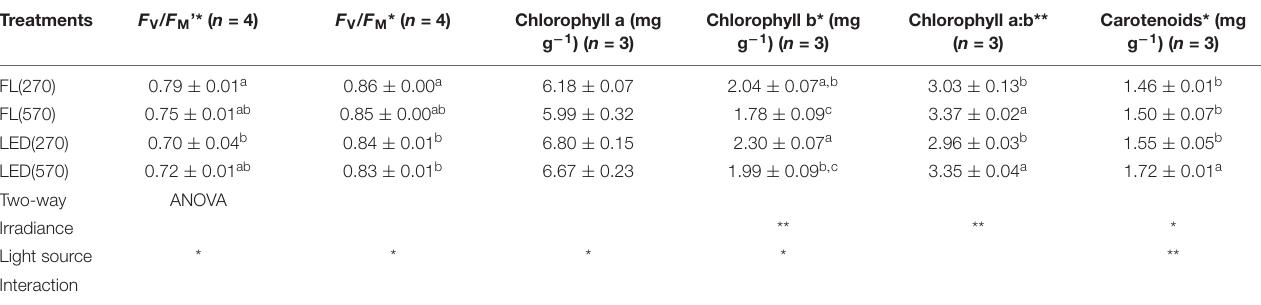
Interaction Values are reported as mean ± standard error of the mean. Different letters within columns indicate significant treatment differences at P < 0 . 05, as determined by Fisher’s least significant difference (LSD) test, with a > b > c. Significance codes (ANOVA): 0.001 “**,” 0.01 “*.”